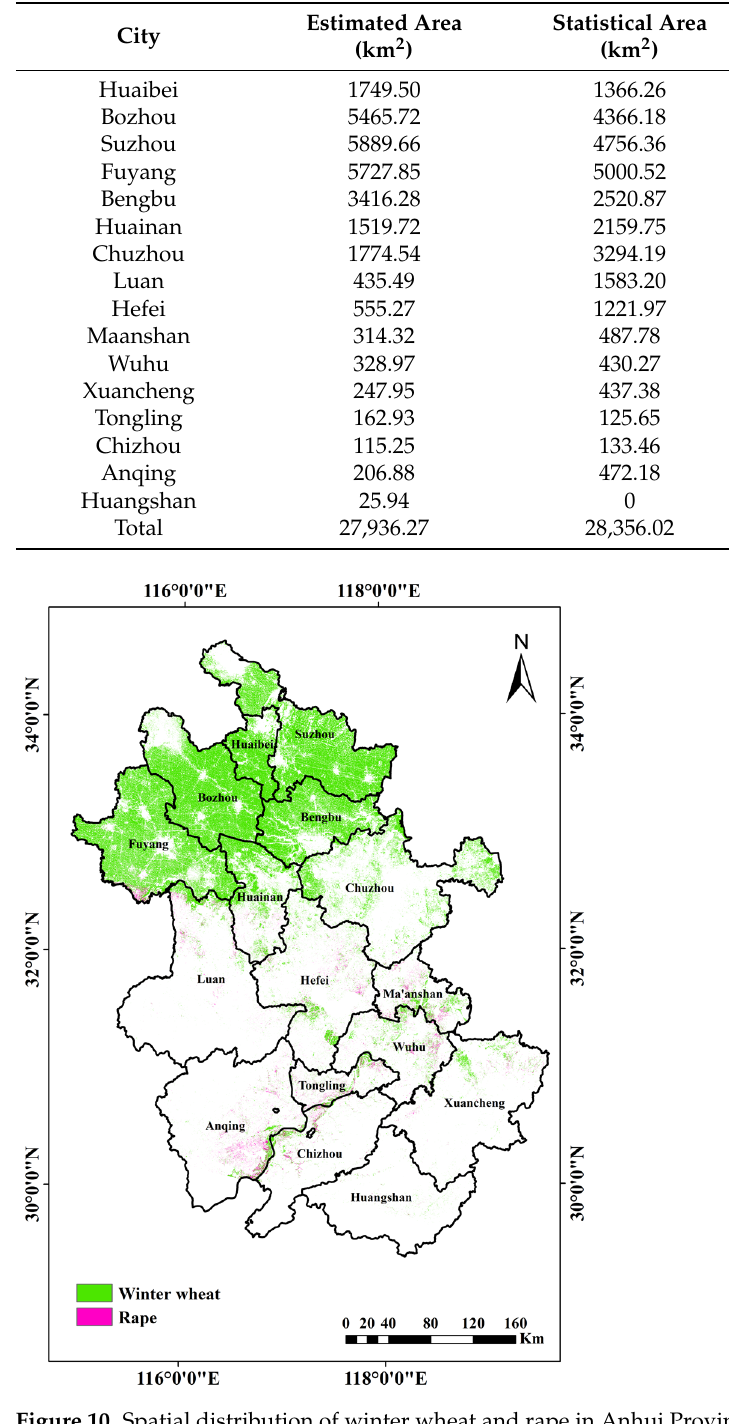
Figure 10. Spatial distribution of winter wheat and rape in Anhui Province.